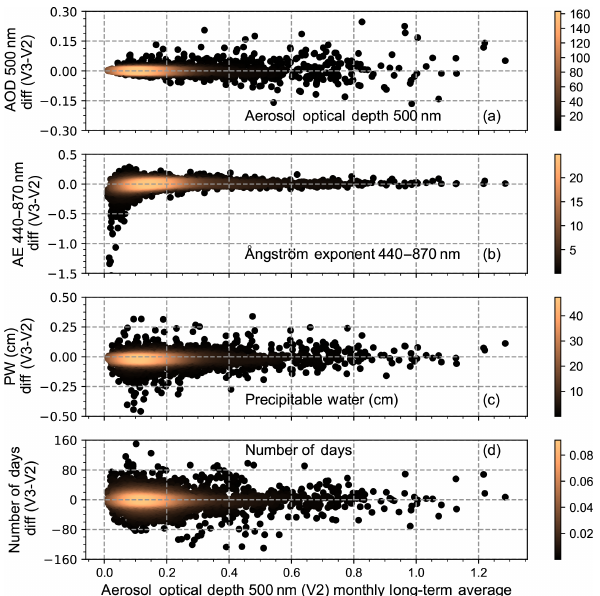
Figure 22. Comparison of Version 3 and Version 2 Level 2.0 mul- tiyear monthly average data sets for time-matched instantaneous observations in both data sets. The panels are similar to those in Fig.